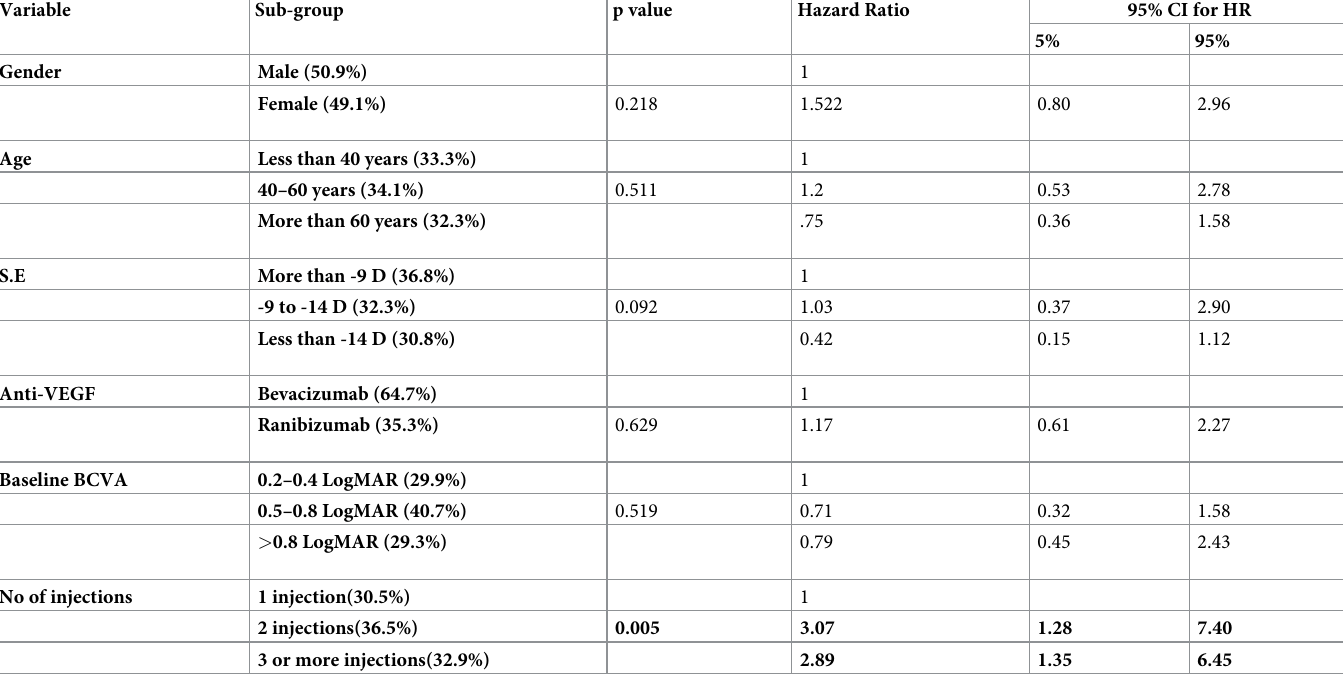
Table 1. Shows the Cox-proportional hazards regression analysis to determine the predictors of recurrence.